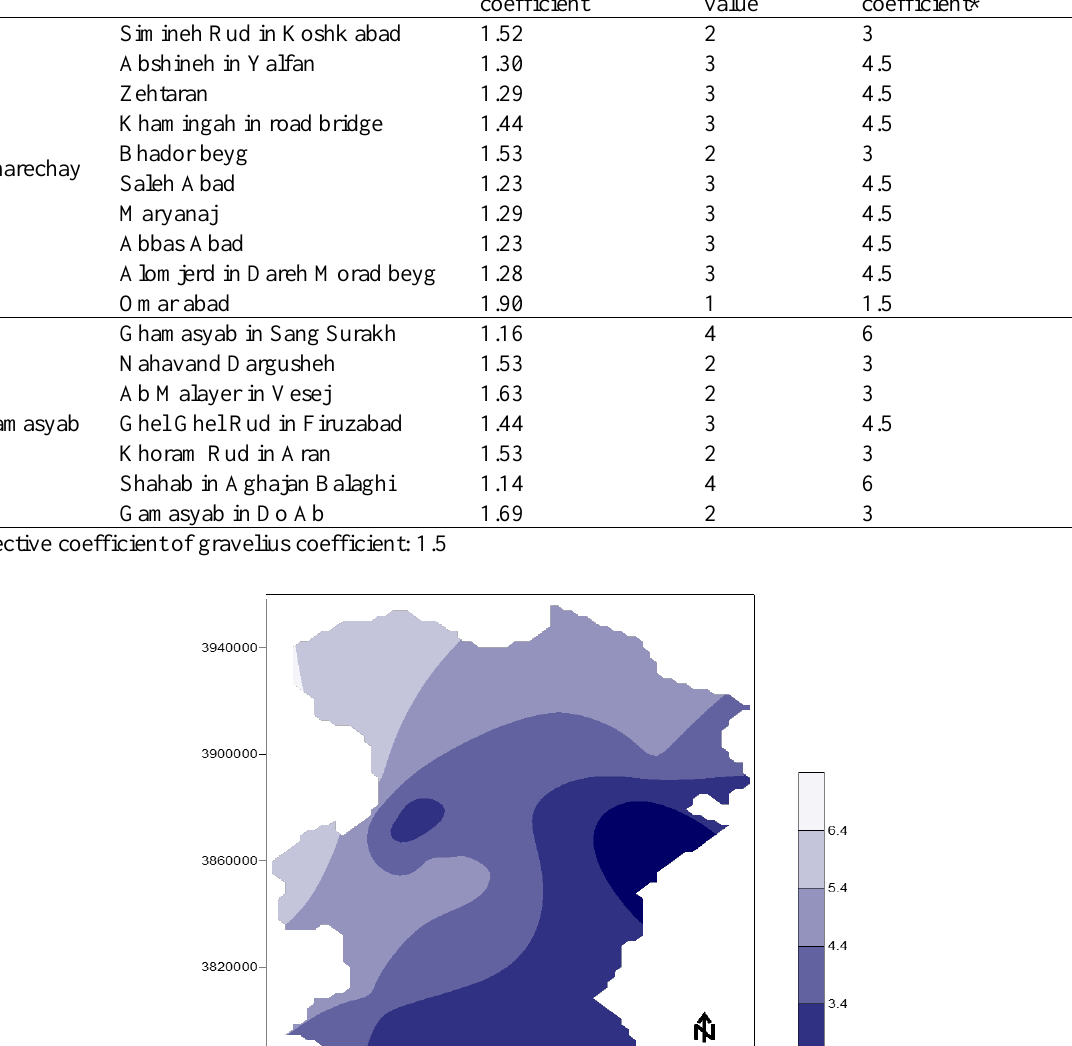
Quantitative Applying affecting value coefficient*